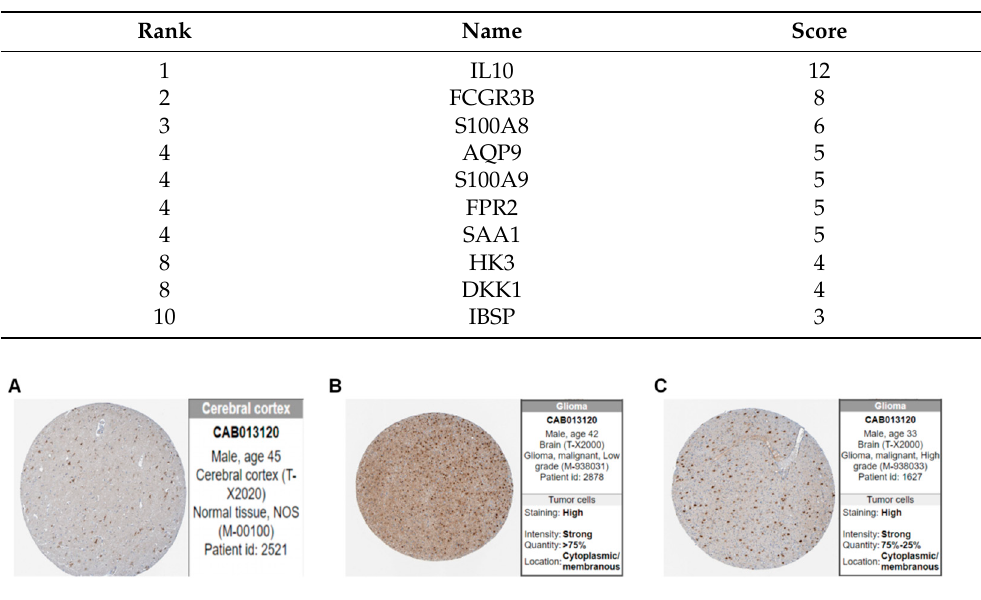
Figure 3. Immunohistochemical image of IL10 on the HPA website. ( A ) Normal tissue. ( B ) Low-grade glioma. ( C ) High-grade glioma. Table 2. Top 10 genes in the network ranked by the Degree method.